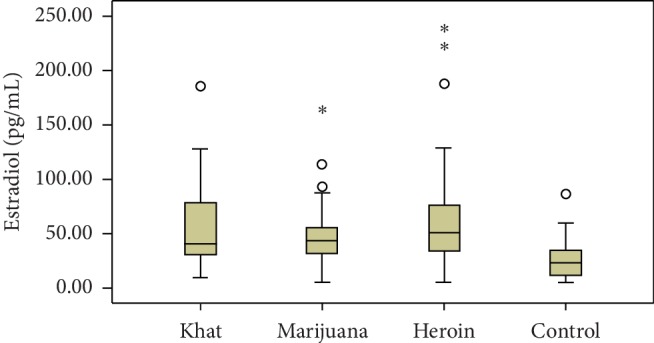
Box and whisker plot data comparison graph of median estradiol hormone levels among khat, marijuana, heroin, and control groups.